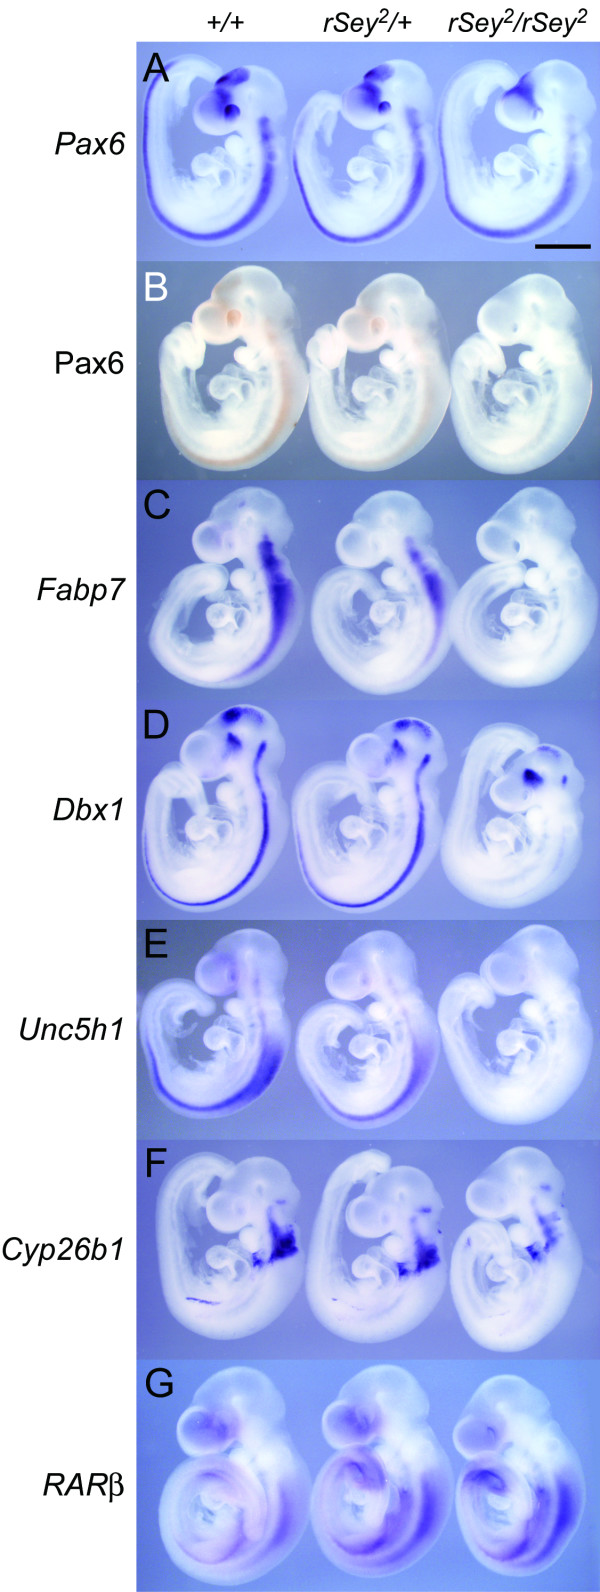
In situ staining of mRNA for down-regulated genes in E11.5 rat whole embryos. (A) Whole mount in situ hybridization (WISH) using an antisense RNA probe for Pax6 [47]. Localization of Pax6 mRNA (blue-violet) was detected in the forebrain, hindbrain and spinal cord of all embryos of the three genotypes. (B) Immunostaining of E11.5 rat embryos with the monoclonal antibody against the PD of Pax6 [14]. The localization of the Pax6 protein (brown) is nearly identical to that of Pax6 mRNA in WT and rSey2/+ embryos. The expression of the Pax6 protein is reduced in the rSey2/+ embryo and is not detected in the rSey2/rSey2 embryo. (C-F) WISH using probes for the down-regulated genes. Expression of Fabp7 (C) and Unc5h1 (E) is reduced in rSey2/+ embryos and not present in rSey2/rSey2 embryos. While there were no significant differences found between WT and rSey2/+ embryos with respect to the expression of Dbx1 (D) and Cyp26b1 (F), the expression of these mRNAs was markedly decreased in the hindbrain (D, F) and spinal cord (D) of the rSey2/rSey2 embryo. (G) WISH using a probe for RARβ. The expression of RARβ is up-regulated in the rSey2/+ embryo and is up-regulated to a greater extent in the rSey2/rSey2 embryo. Scale bar: 1 mm.